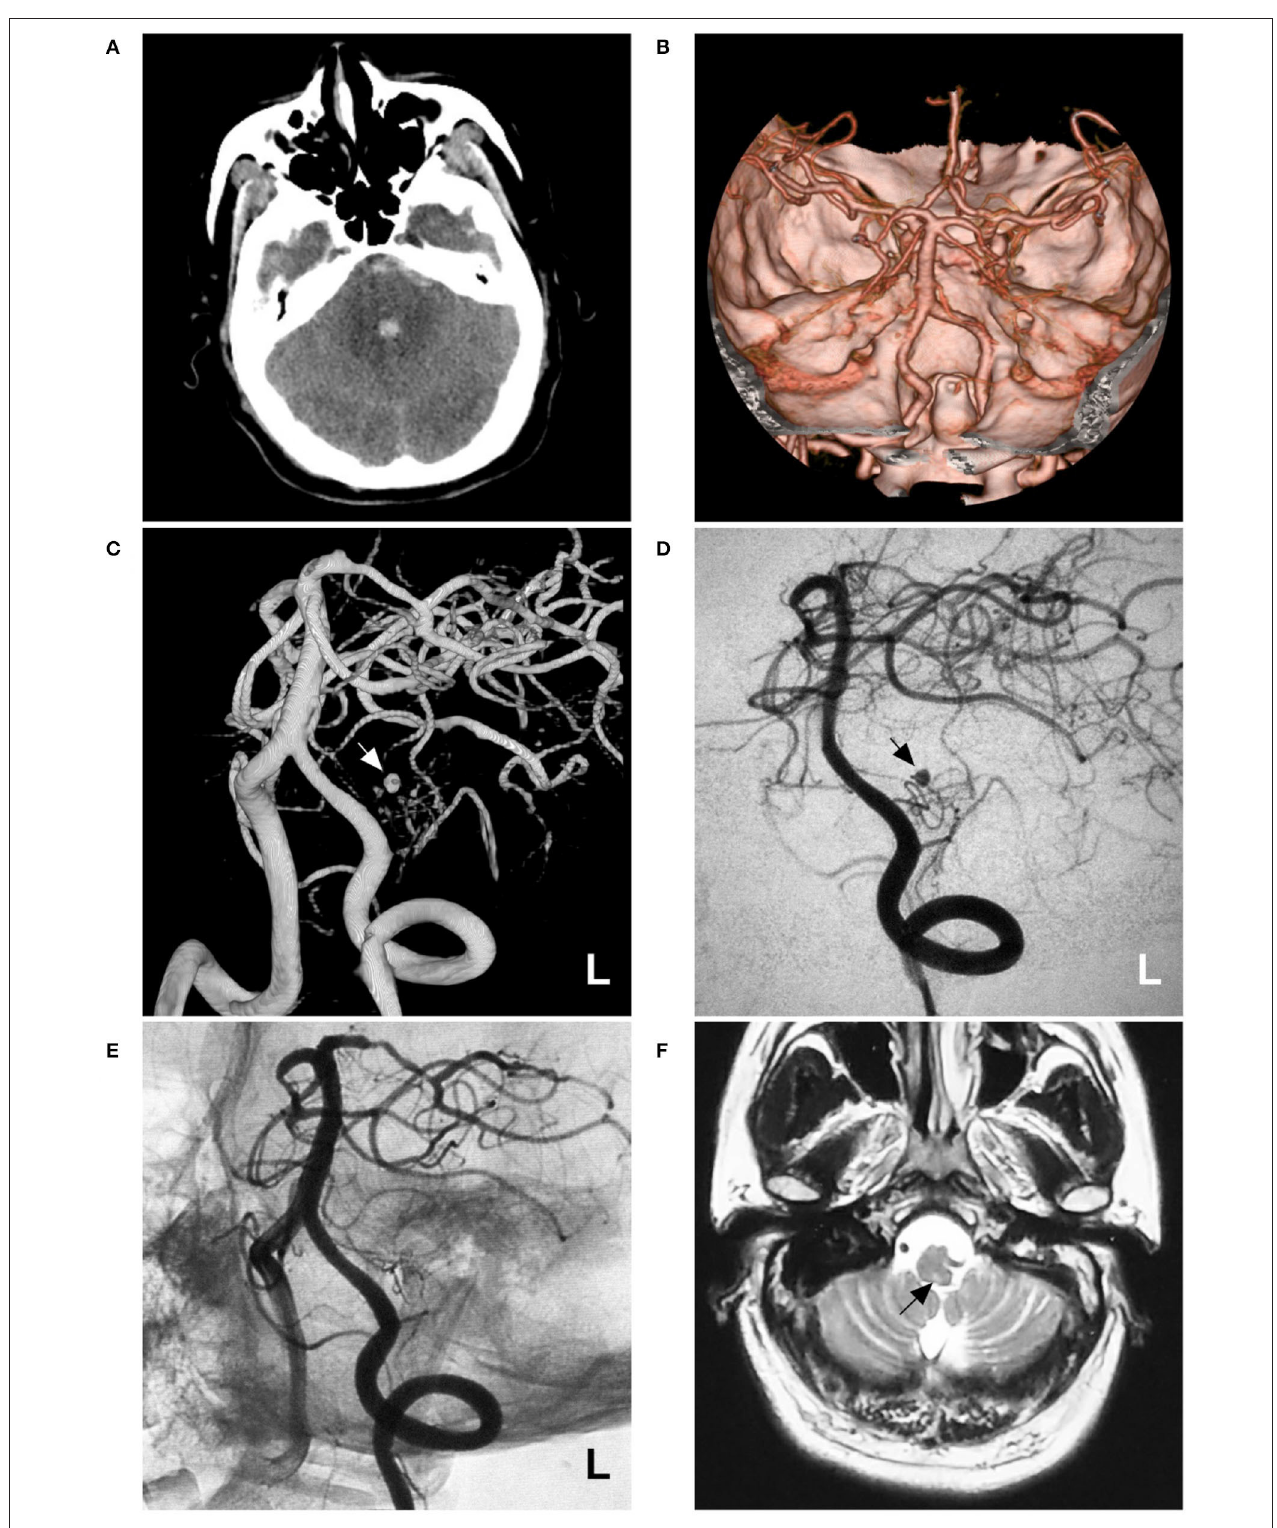
FIGURE 1 | Imaging of case 1. (A) CT shows subarachnoid hemorrhage concentrated at the perimesencephalic cistern with involvement of the fourth ventricle. (B) CTA reveals no underlying vascular lesions. (C,D) Angiograms of the left VA show a pseudoaneurysm (arrow) located in the hypoplastic and plexiform PICA. (C) shows a three-dimensional angiogram, and (D) shows a two-dimensional angiogram. (E) Angiogram of the left VA shows that the aneurysm and parent PICA are cast with Onyx, and other branches are visualized. (F) Follow-up MRI scan shows a minor brainstem infarction (arrow). CT, computed tomography; CTA, CT angiography; L, left; MRI, magnetic resonance imaging; PICA, posterior inferior cerebellar artery; VA, vertebral artery.